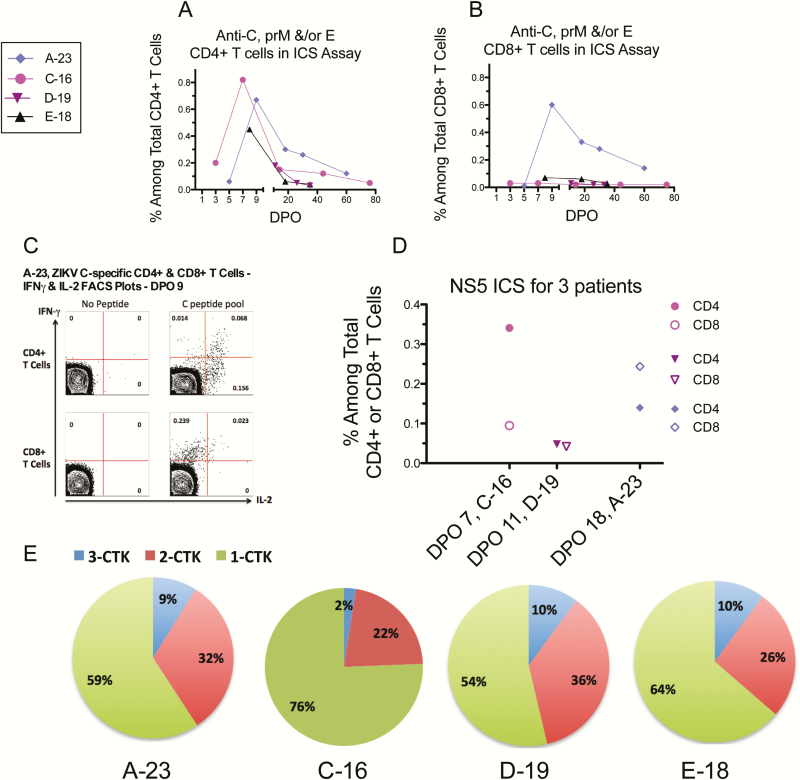
T-cell intracellular cytokine staining (ICS) assays. CD4+ or CD8+ T cells were stimulated for 6 hours with peptide pools spanning Zika virus (ZIKV) C, prM, E, or NS5 proteins. Thawed peripheral blood mononuclear cells from various days post symptom onset were used in these assays. Antiviral cells expressing intracellular cytokines (interferon [IFN]-g, interleukin [IL]-2, and/or tumor necrosis factor-a) were then detected by ICS and flow cytometry. A and B, ZIKV C-, prM-, and/or E-specific cytokine-producing CD4+ or CD8+ T cells. Summary results are presented here as pooled total cytokine-producing cells analyzed in a Boolean analysis. C, FACS plots demonstrating C-specific CD4+ and CD8+ T cells for patient A-23. CD8+ cells produced primarily IFN-g, whereas CD4+ cells produced both IFN-g and IL-2. D. NS5-specific T cells were assessed with available cells for 3 patients. Closed symbols, CD4+ T cells; open symbols, CD8+ T cells. Patent D-19’s result was negative (as defined in Supplementary Table S1 footnote). E, Polyfunctionality of the CD4+ T cells. The pie charts display the relative proportions of CD4+ T cells producing 1, 2, and 3 cytokines (CTK) (Boolean analysis); 3 CTK (blue), percentage of cells producing all 3 cytokines; 2 CTK (red), cells producing 2 cytokines; and 1 CTK (green), cells producing a single cytokine. Abbreviations: CTK, cytokine; DPO, days post onset of symptoms; FACS, fluorescence activated cell sorter; ICS, intracellular cytokine staining; IFN, interferon; IL, interleukin; ZIKV, Zika virus.